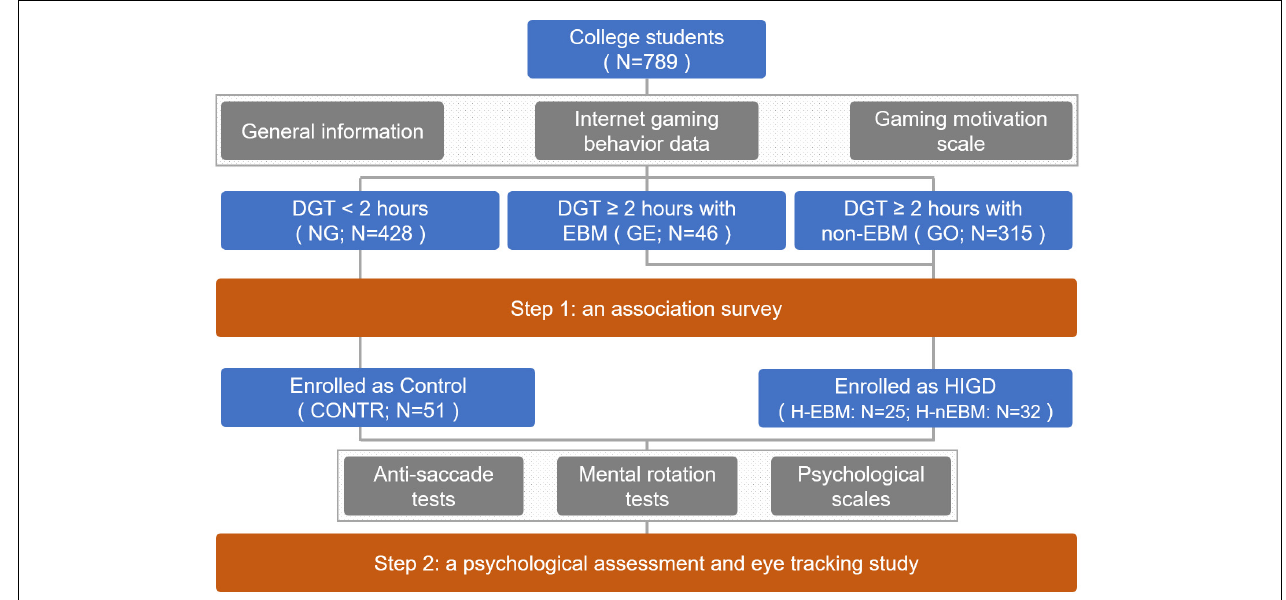
FIGURE 1 | Participants’